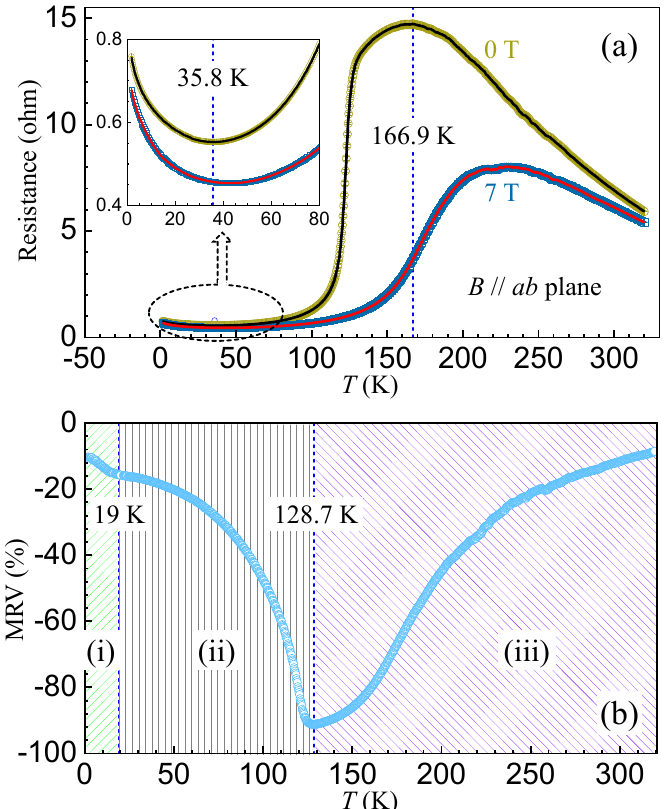
Figure 6. (color online) ( a ) Measured resistance (circles) within the crystallographic ab plane of a La 1.37 Sr 1.63 Mn 2 O 7 single crystal with applied magnetic fields B (0 and 7 T) perpendicular to the electric current direction in a temperature range from 1.67 to 322 K. Inset is an enlarged image of the data in the temperature range of 1.67–80 K. Error bars are standard deviations, and some are embedded into the symbols. The solid lines are fits to the data (see details in the text); ( b ) calculated MRV as a function of temperature at 7 T ( see detailed analysis in the